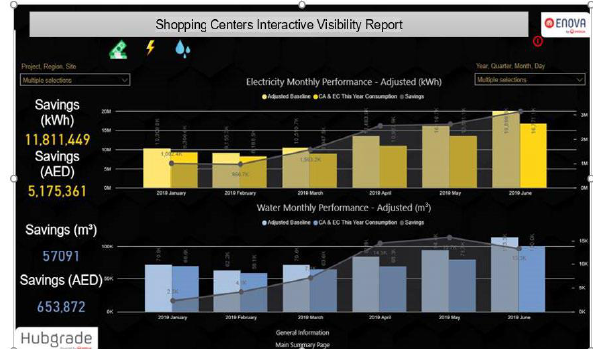
Figure 5: Dashboard for energy optimisation results for